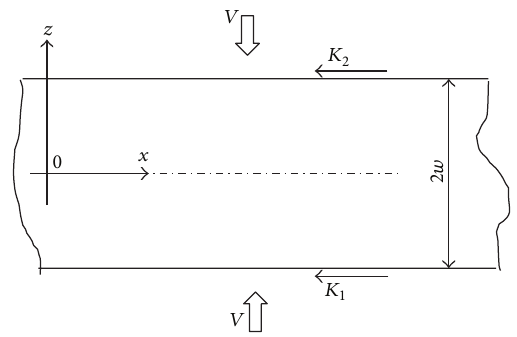
Figure 2: Compression of a single layer between rough rigid